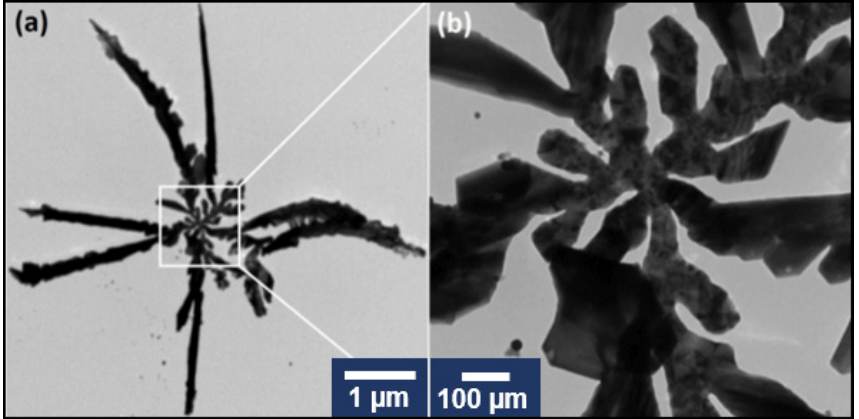
Figure 2. TEM image of a typical individual silver nanostar ( a ). TEM image of the central zone of the nanostar ( b ).